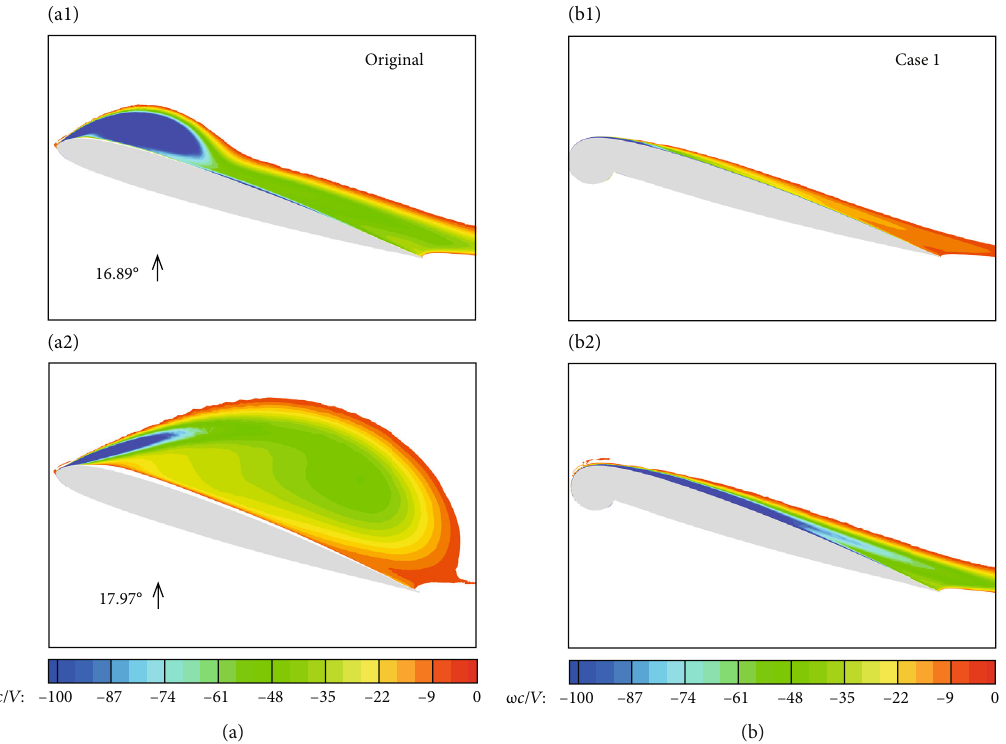
Figure 18: Contours of vorticity magnitude of the original airfoil and the ILE airfoil in Case 1 at di ff erent angles of